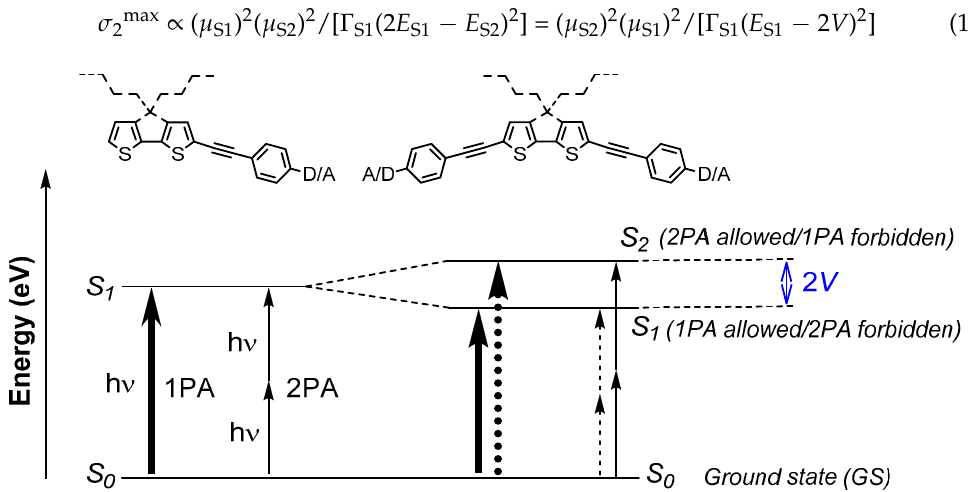
Figure 10. Change in allowed (plain arrows)/forbidden (dashed arrows) 1PA and 2PA transitions in the essential state models upon increasing branching in triphenylamine-based derivatives (D/A = electron-releasing/withdrawing groups).